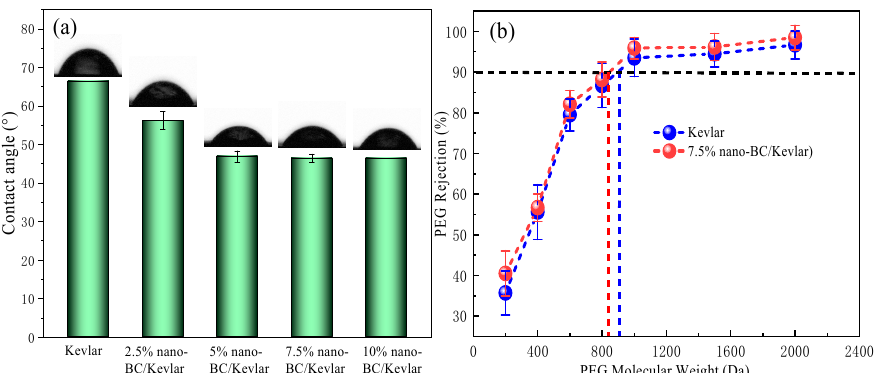
Figure 5. ( a ) The water contact angles of different membrane samples; ( b ) The MWCO of Kevlar and 7.5% nano-BC/Kevlar membranes.